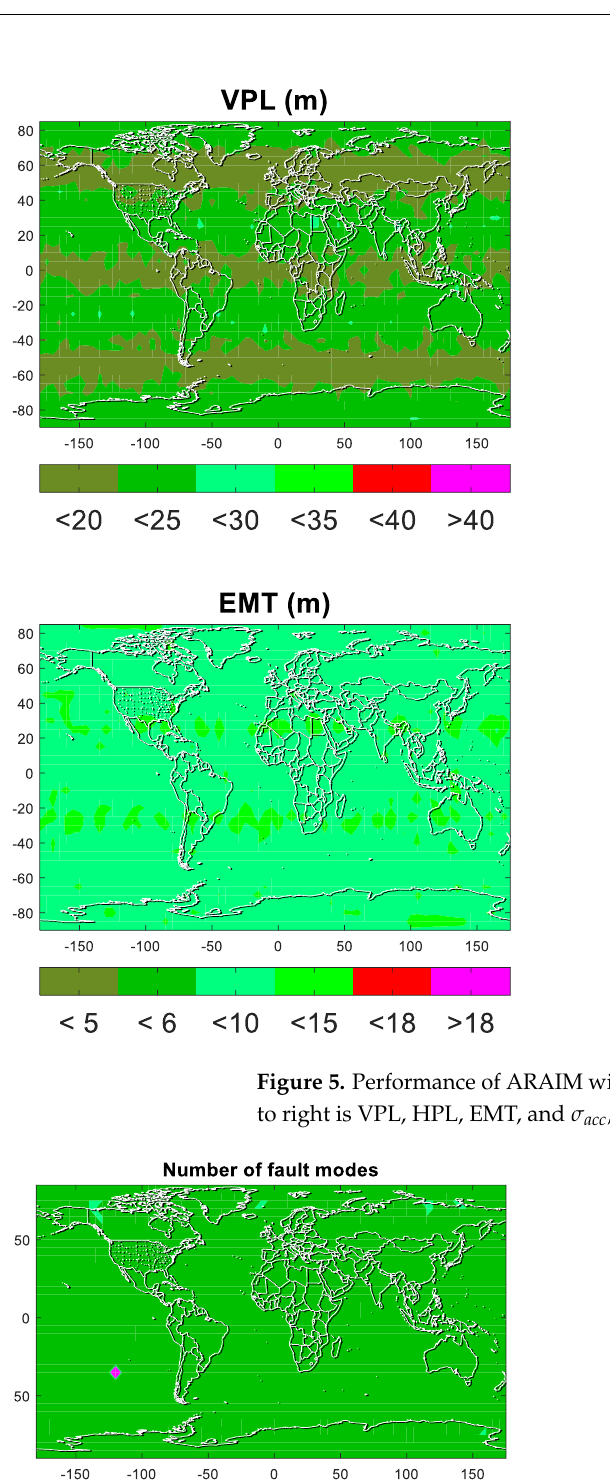
Figure 7. Selection of constellation combination in one sidereal day. Figure 8. Worldwide distribution of constellation combination. 16 % 18 % 20 % 17 % 15 % 14 % N u m b er o f c o n s t e ll a t i o n c o m b i n a t i o n f o r ARA I M 1 G PS + G L O 2 G PS + GA L 3 G L O + GA L 4 G PS + B D S 5 G L O + B D S 6 GA L + B D S